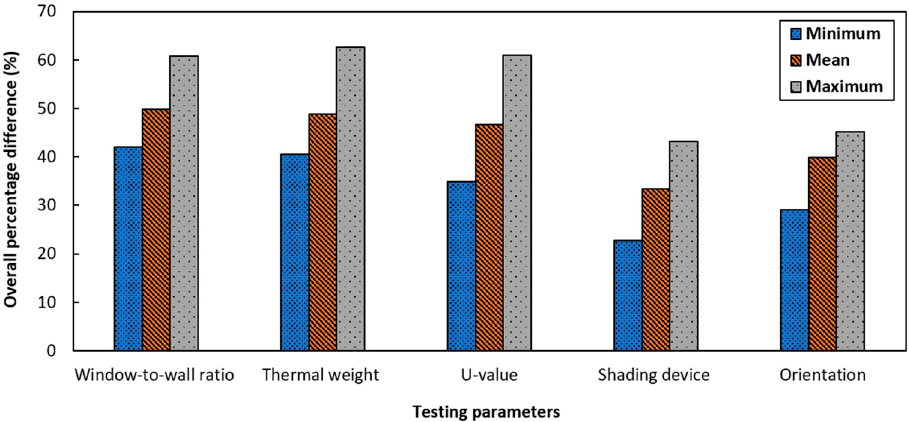
Figure 9. Overall differences in peak cooling load affected by different parameters between CIBSE admittance and ASHRAE RTS methods.